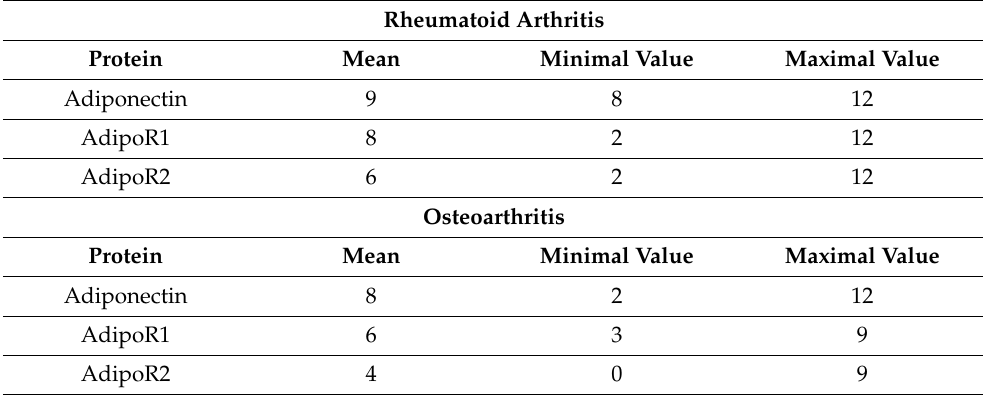
Table 3. Immunoreactive scores (IRS) for synovial membrane. IRS values: 0—negative, 1–6—weakly positive, 7–12—strongly positive.